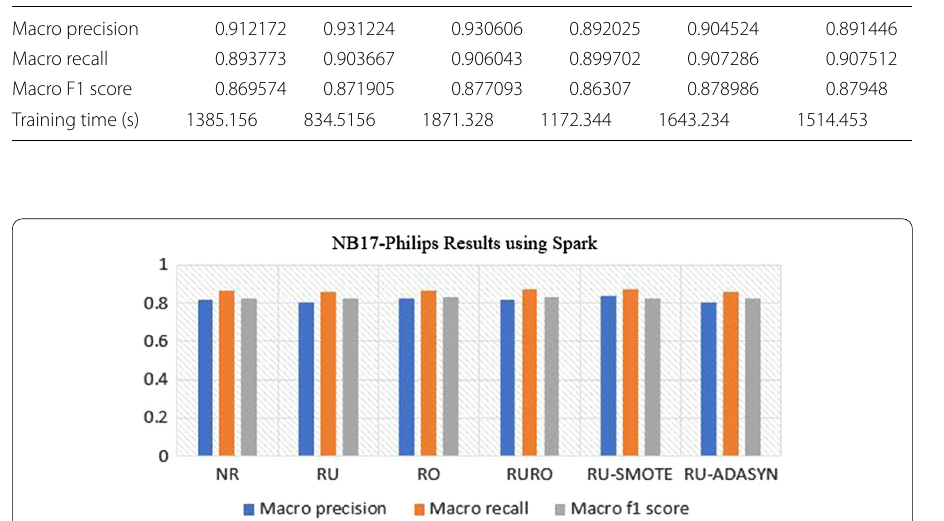
Fig. 17 ANN classification results for NB17-Philips on AWS with Spark for various resampling